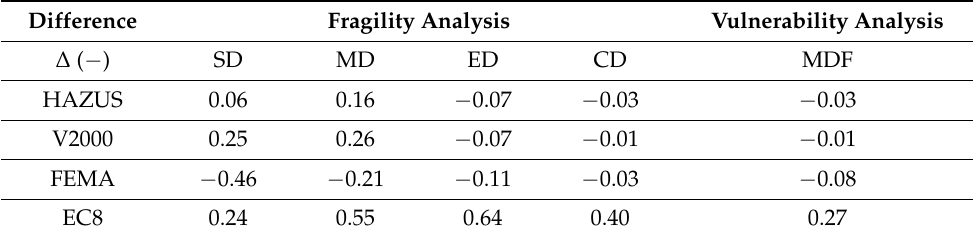
Table 4. The differences for the value of the design PGA compared to the modified DI.